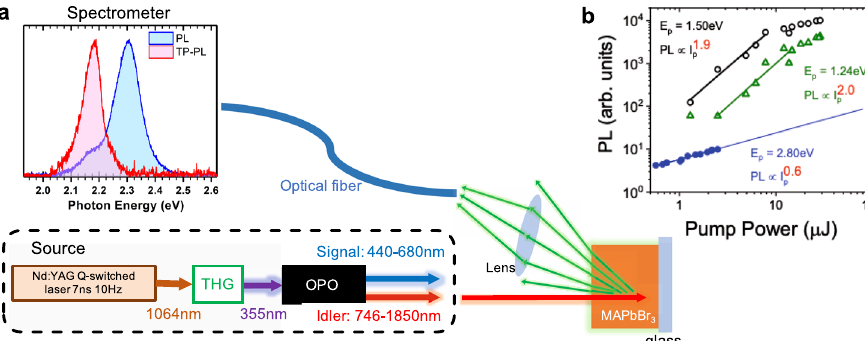
Fig. 2 Measurement of two-photon photoluminescence of hybrid organic – inorganic perovskite crystals. a Schematic of the experimental set-up in which the spectrally tunable output of an optical parametric oscillator (OPO) seeded by the combination of an Nd:YAG Q-switched laser and third-harmonic generator (THG) is used as excitation light source for the photoluminescence (PL) emission from the perovskite crystals. The PL emission spectrum from MAPbBr 3 crystal is shown for one-photon excitation (blue) and two-photon excitation (red). b Log – log plot of the pump intensity ( I p ) dependence of the PL emission at excitation photon energies ( E p ) of 1.24 eV (green open triangles), 1.50 eV (black open circles), and 2.80 eV (blue solid circles). Solid lines are linear fi ts to extract the power law as indicated.